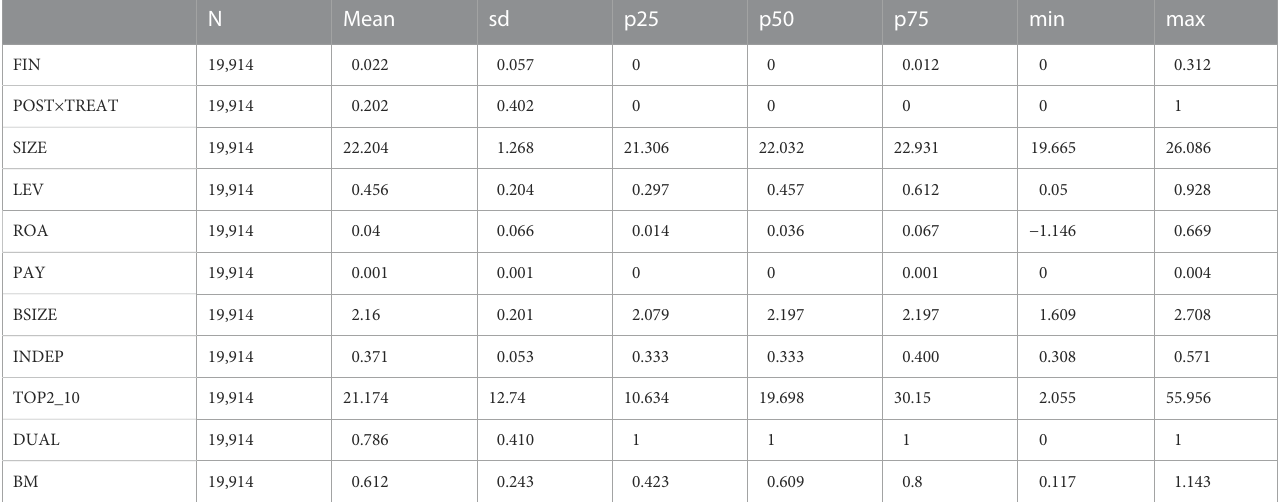
TABLE 2 Descriptive statistics of the